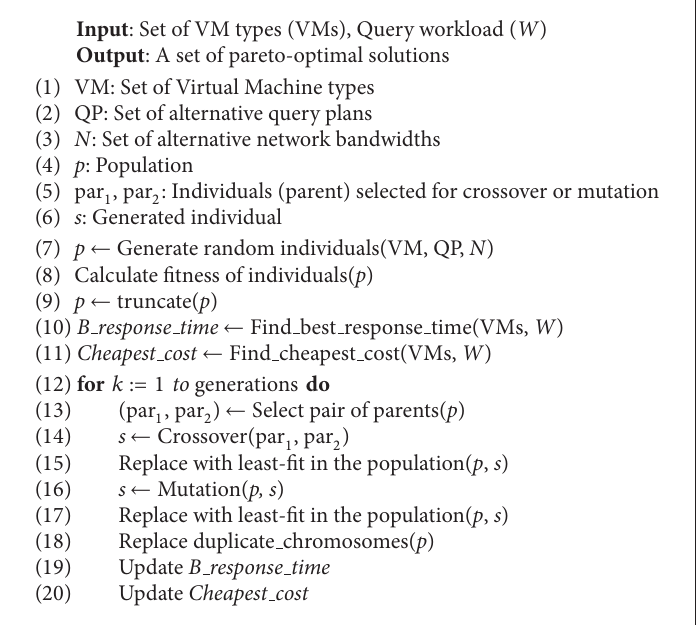
Algorithm 2: Multiobjective optimization of cloud database configuration using genetic algorithm.